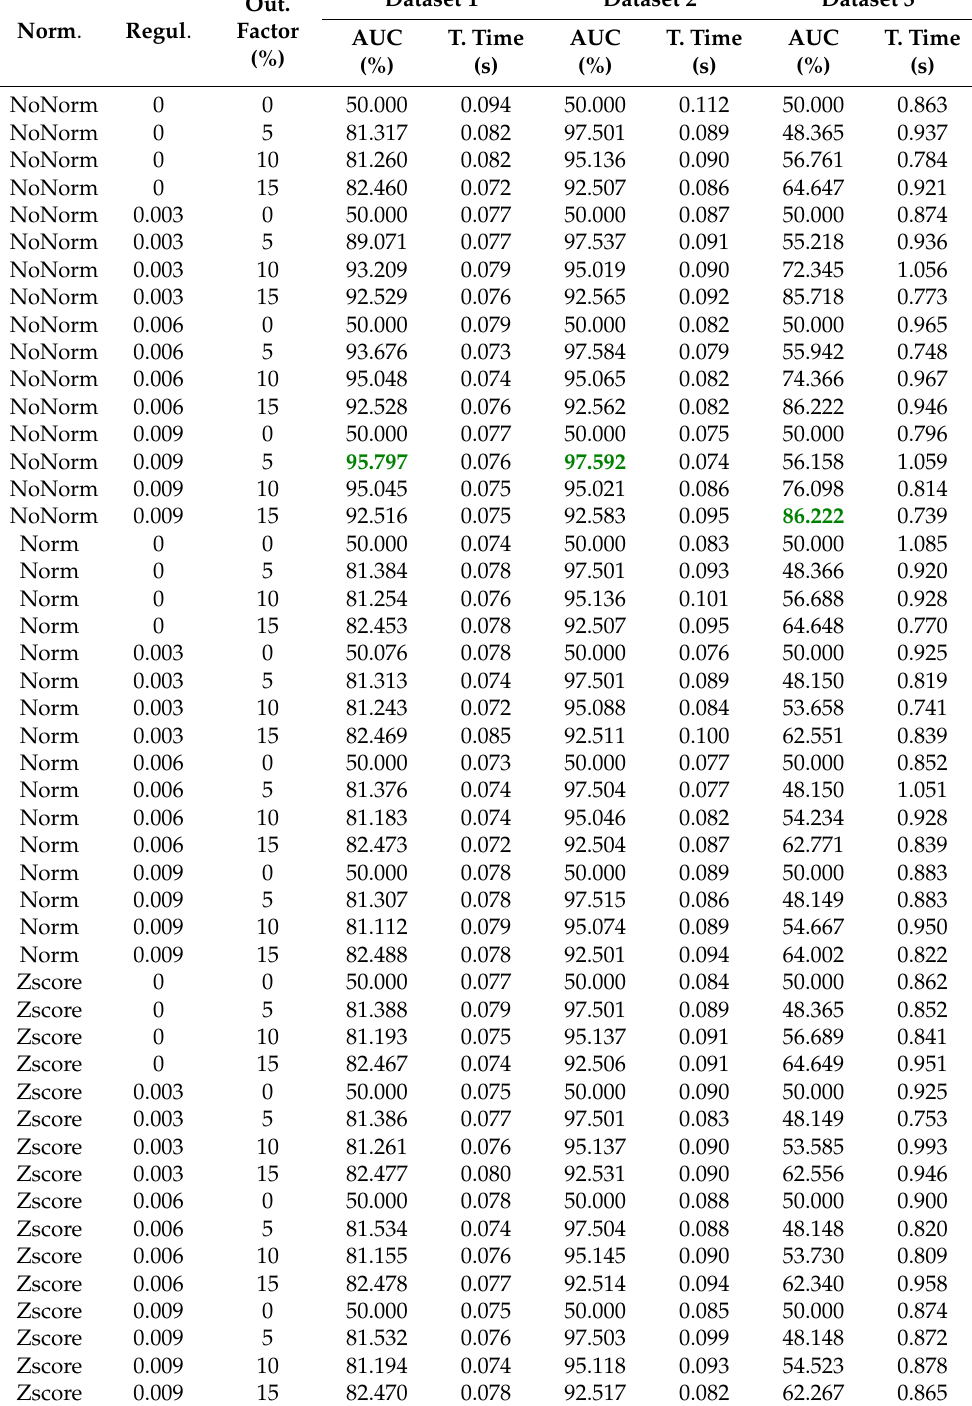
Table 2. Gaussian model